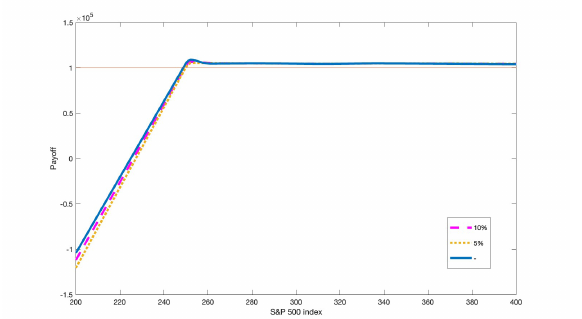
Figure 6. The transaction cost of the portfolio payout.